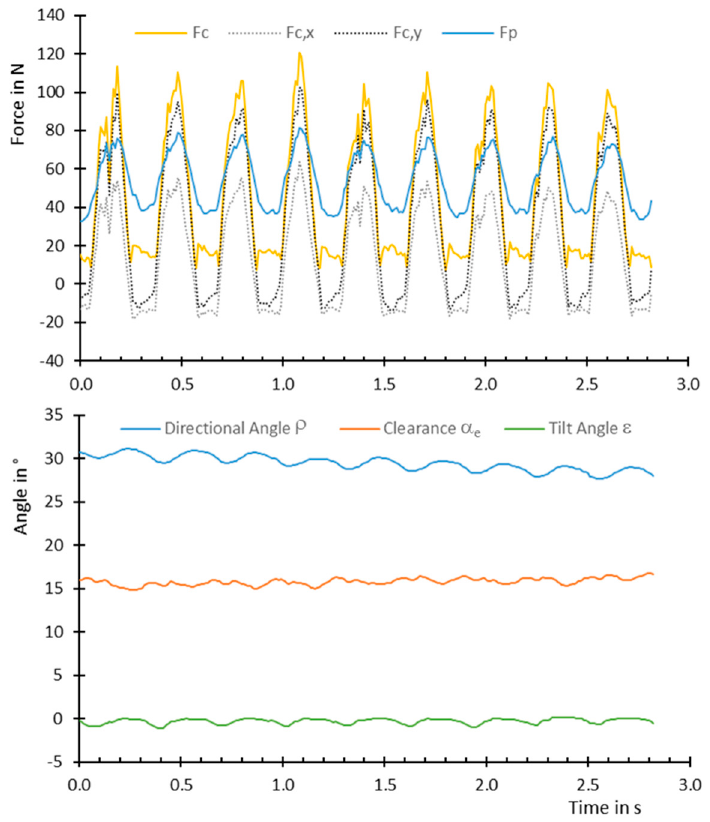
Figure 8. Forces and tool orientation of nine consecutive scraping cycles.